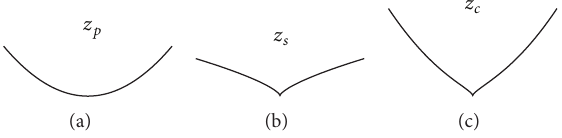
Figure 4: (a) Parabolic shape 𝑧 𝑝 ; (b) indenter shape 𝑧 𝑠 according to (6) with 𝐻 = 0.7 ; (c) superposition 𝑧 𝑐 of